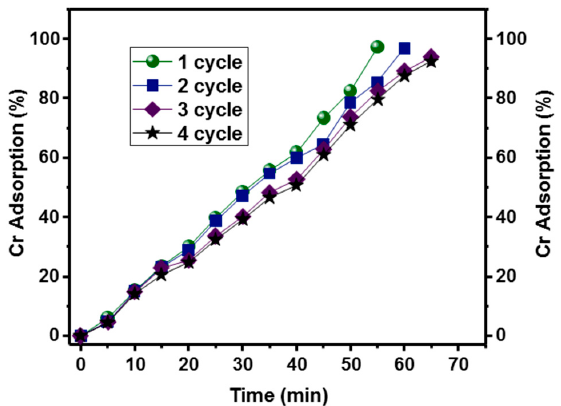
Figure 6. Reusability of G/PANI/FG1 for the adsorption of Cr (VI). Cr (VI) = 0.5 mM, pH = 2, and temperature = 25 °C.